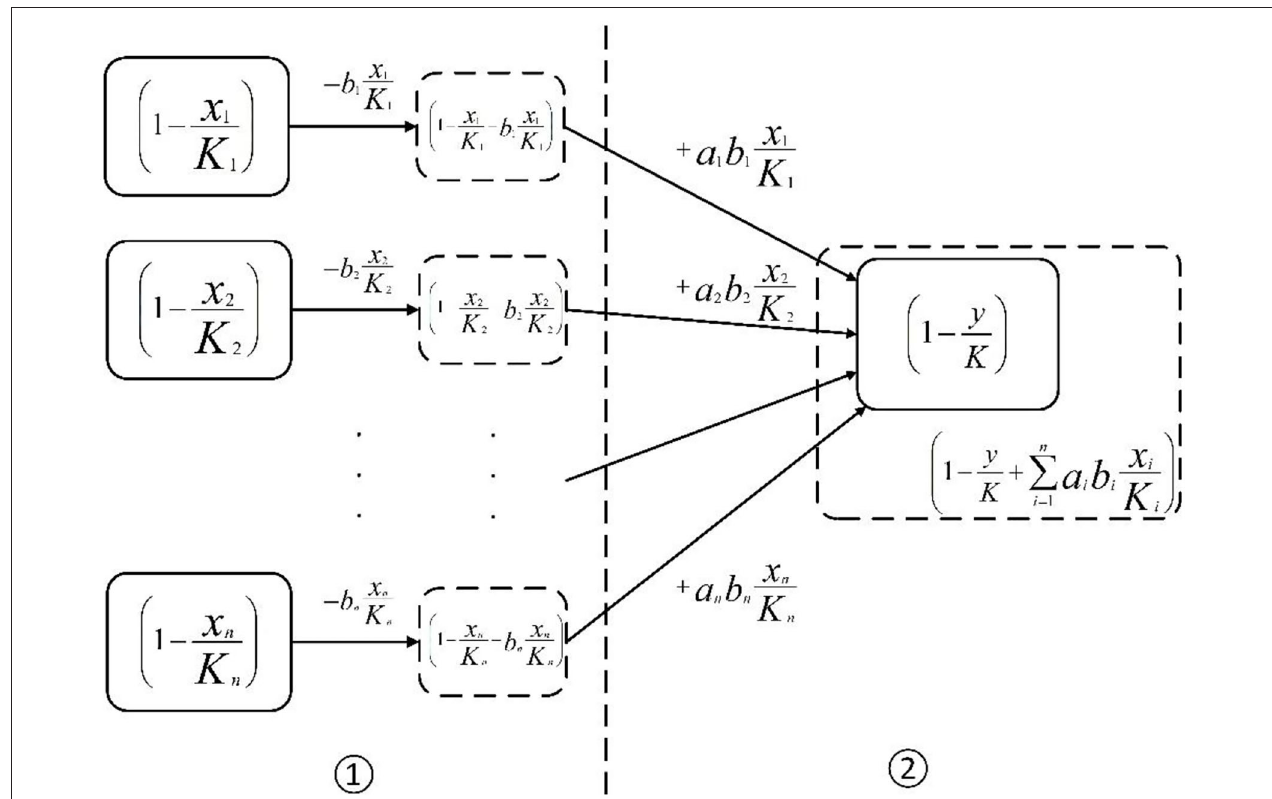
FIGURE 2 | The transfer process of emotional information.